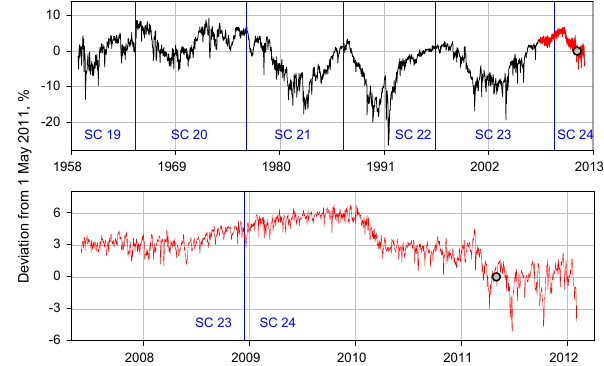
Fig. 4. Variations in time of the high-energy cosmic-ray neutrons measured with a neutron monitor (Simpson, 2000) at Jungfraujoch, Switzerland (data from Neutron Monitor Data Base, http://www. nmdb.eu/nest/search.php, accessed on 2 February 2012), and re- ported as relative difference from the value on 1 May 2011 ((value- value1may11)/value1may11). The data shown in black have a reso- lution of ten days, while those in red have a resolution of one day. The lower panel and the red line in the upper panel show the data between 2007, when the longest continuously running COSMOS probe was installed, and today. The blue lines separate solar cycles (SC). Solar cycles are on average 11yr long, but vary from nine years to